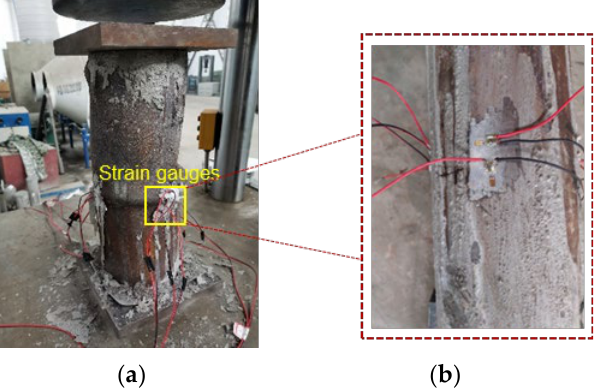
Figure 6. CFST testing under compressive loading: ( a ) experimental setup; ( b ) strain gauges (enlarged).